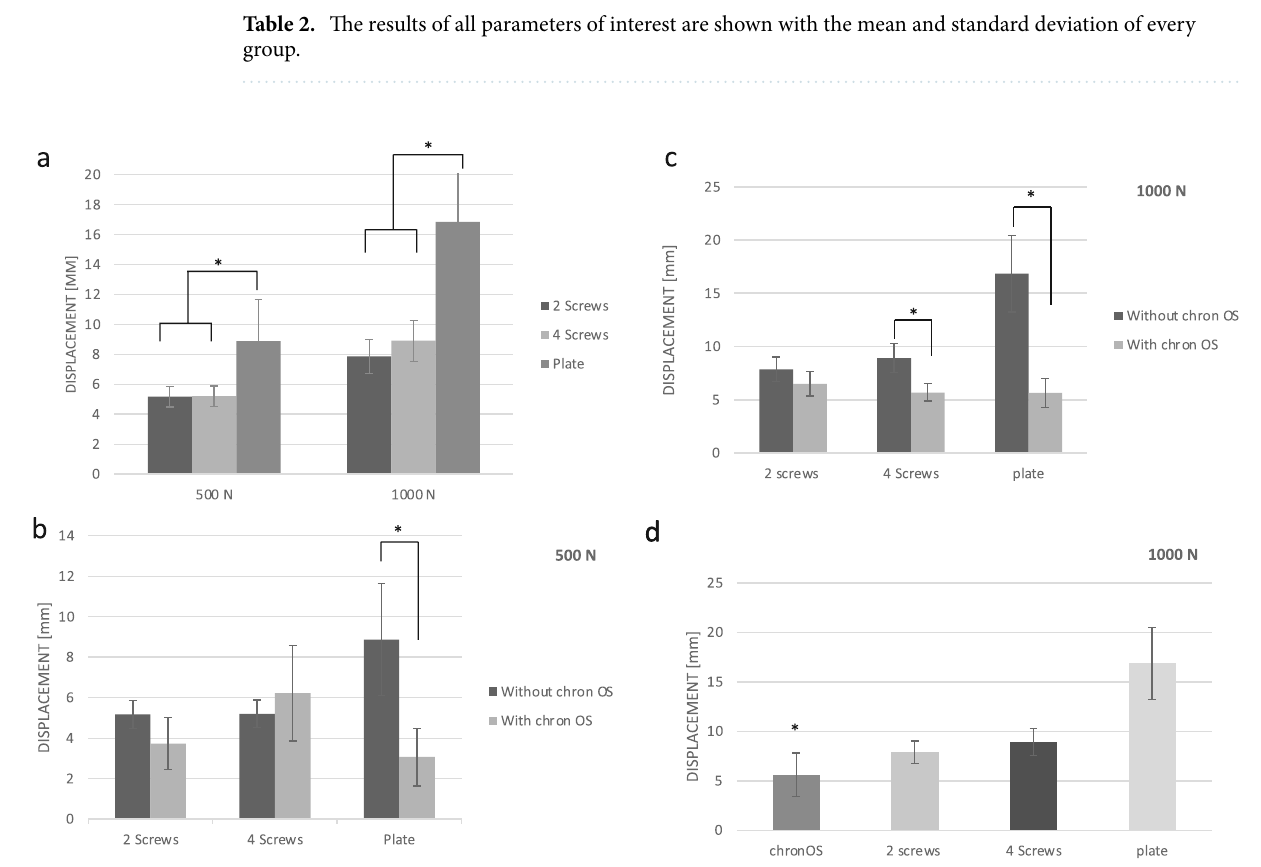
Figure 3. The results analysing the displacement of both loading levels is shown. Means ± SD, significant differences are indicated by *(p < 0.05 between groups). ( a ) In both loading levels, the plate osteosynthesis revealed a higher displacement compared to the screw osteosyntheses. ( b ) Comparing the different types of osteosyntheses alone and in combination with bone cement to each other, a significant lower displacement was determined for plate osteosynthesis in the 500 N loading level. ( c ) In the 1000 N testing series, a lower displacement was detected for the combination with bone cement for the 4 screw and the plate osteosynthesis. ( d ) The group with bone filler only (ChronOS™ inject) revealed a lower displacement in the 1000 N loading level compared to the three types of osteosyntheses